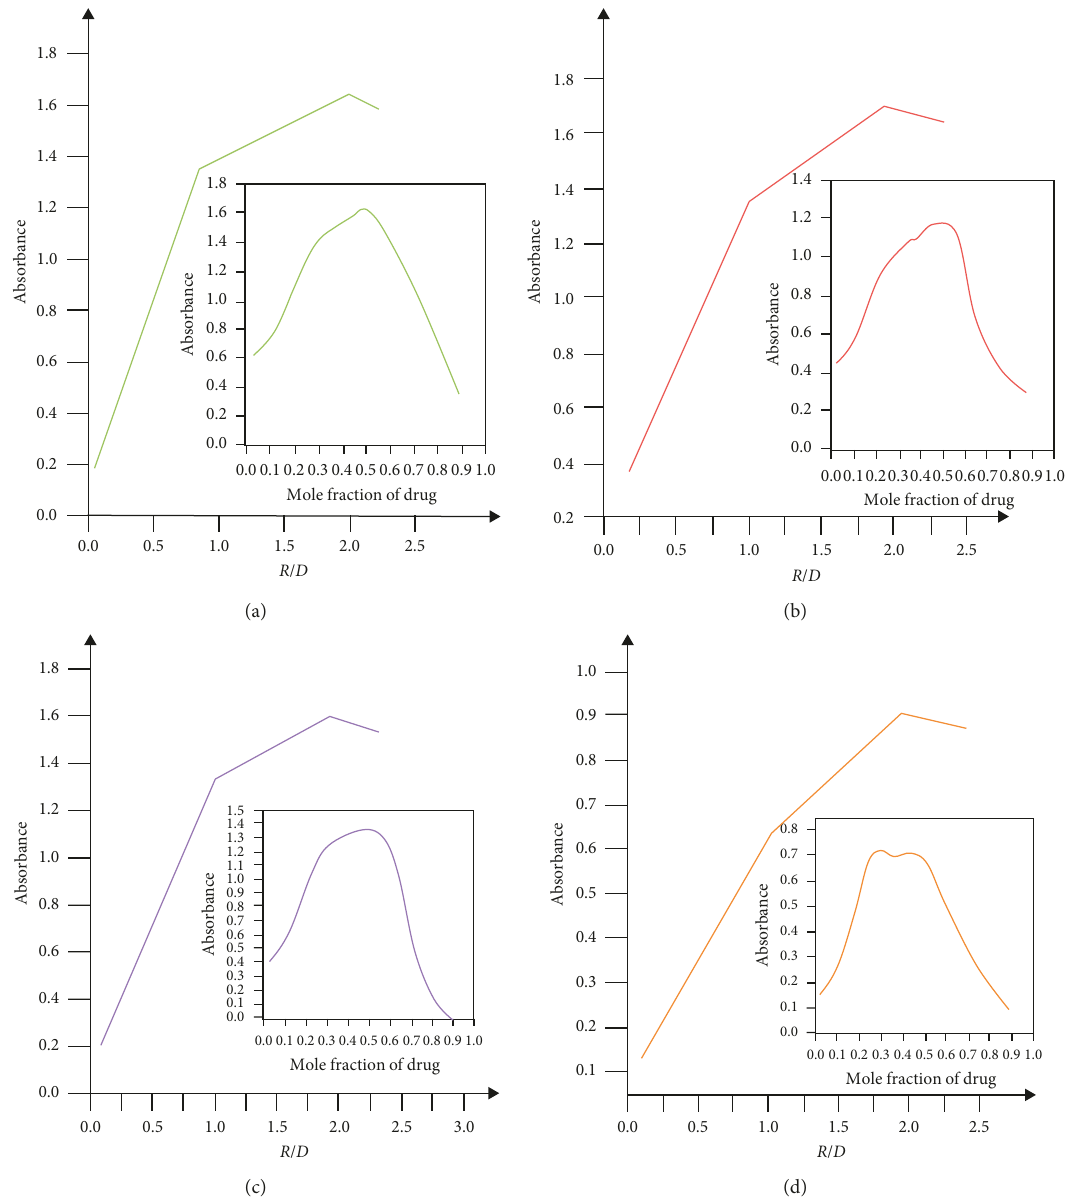
Figure 2: Stoichiometry of formed complexes between diaveridine and reagents V (a), VI (b), VII (c), and VIII (d) complexes by MRM and CVM